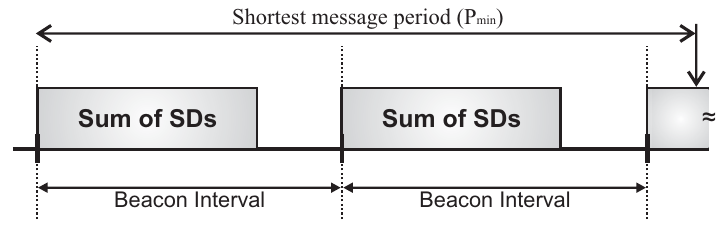
Figure 7. Shortest Beacon